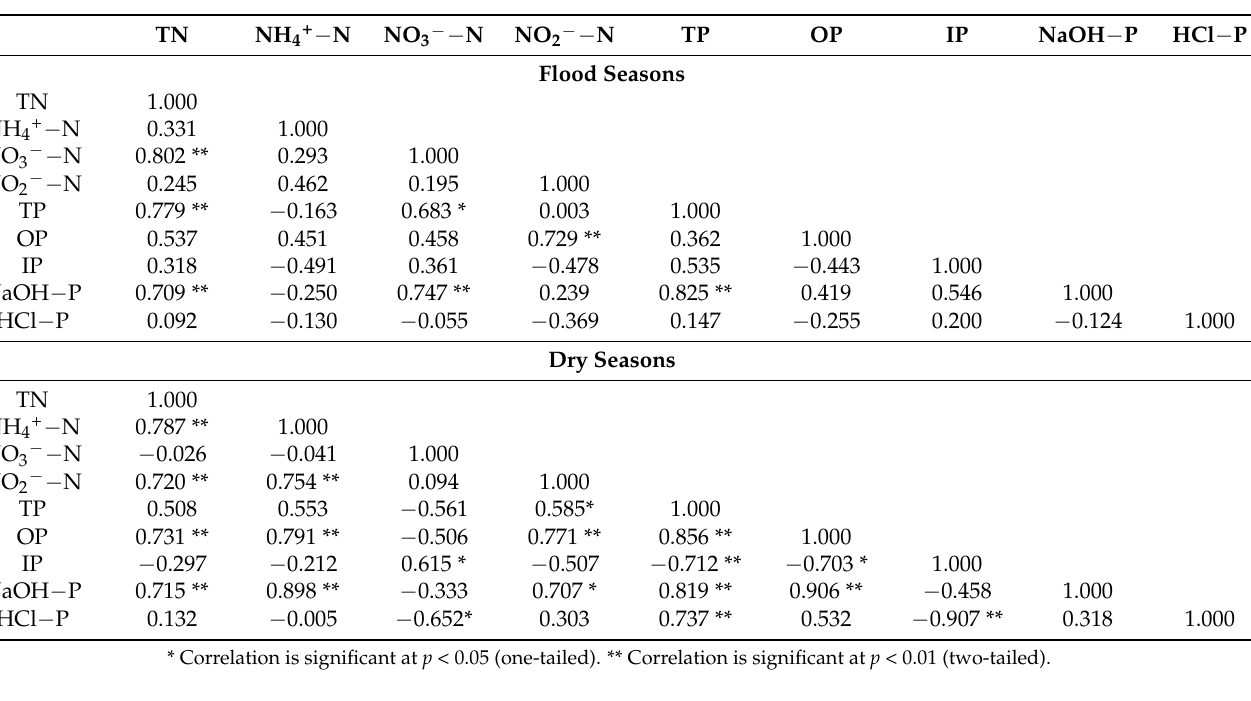
Table 2. Pearson correlation matrix between nutrients in sediments of the QCS Reservoir in flood and dry seasons (n = 48).